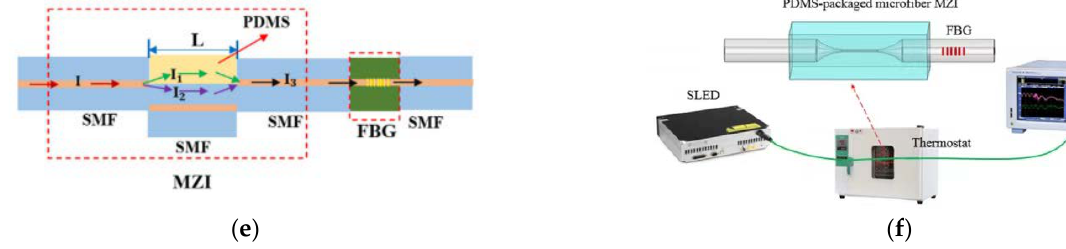
Figure 1. ( a ) Schematic diagram of the dislocation fiber MZI-based sensor [48]. ( b ) Schematic of HBEF sensor based on a Sagnac loop [51]. ( c ) Schematic diagram of an SI based on a PMF with a circle [53]. ( d ) Diagrammatic sketch of the PDMS-coated microfiber sensors [60]. ( e ) The sensing probe with cascaded MZI and FBG [62]. ( f ) Schematic of temperature measurement system [63].